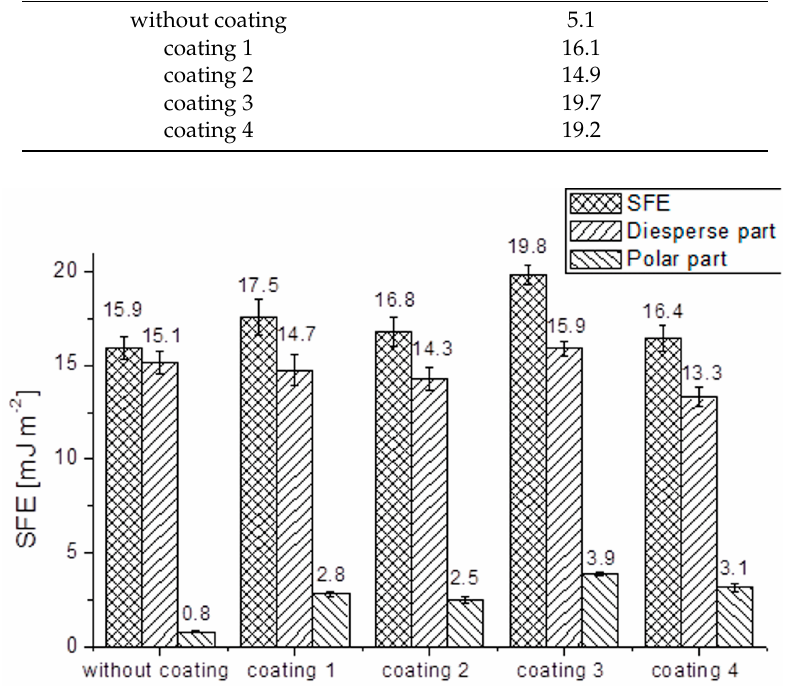
Figure 9. Surface free energy of fibers.